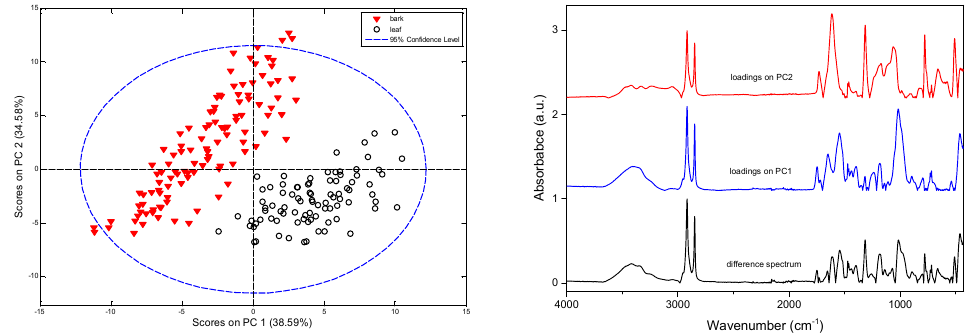
Figure 5. PCA for ATR spectra of poplar bark and leaves for merged data sets: left —score plots and right —plots of the absolute values of the PC1 and PC2 loadings and subtraction result between the average leaf and bark spectra.